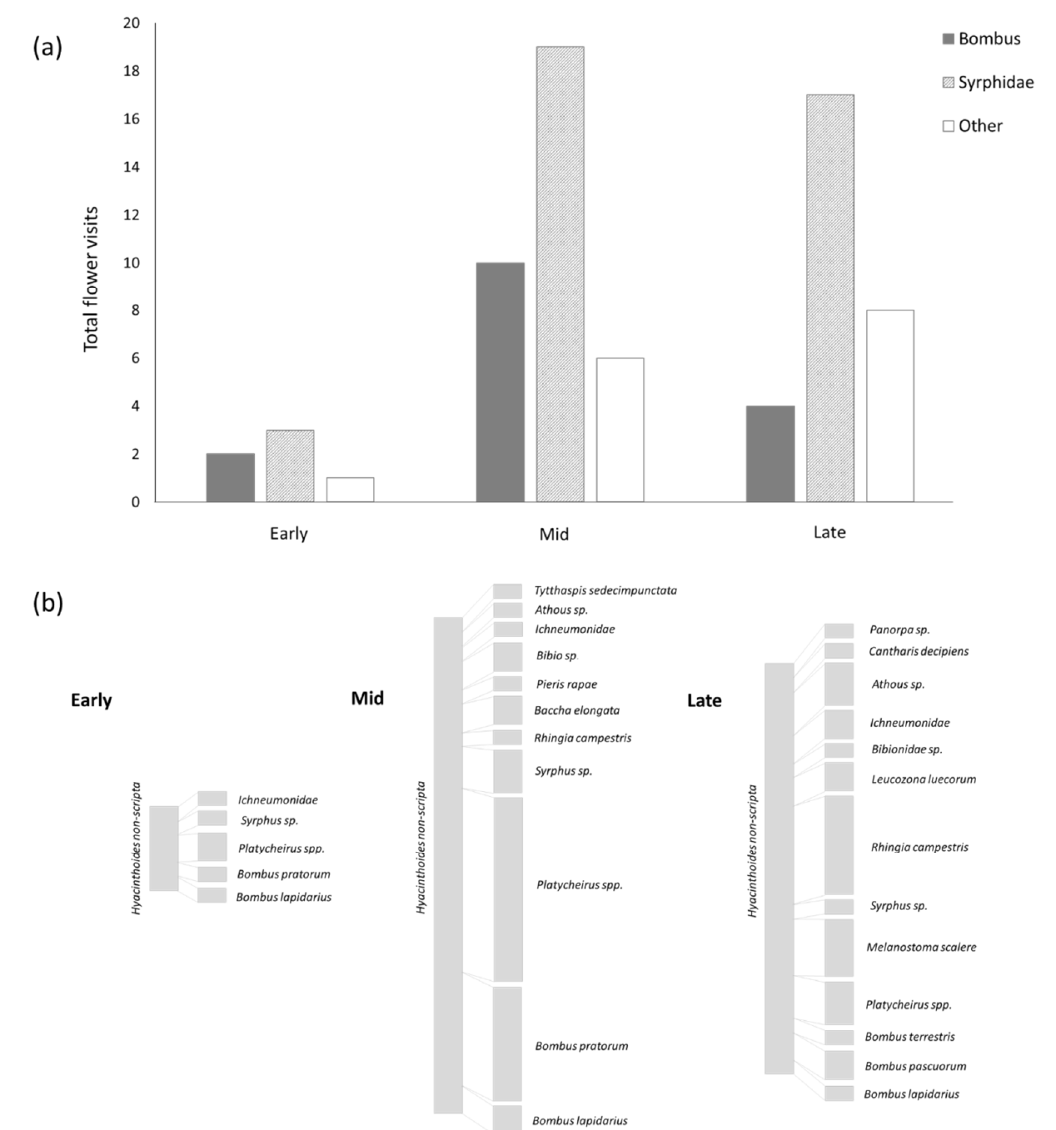
Figure 3. ( a ) Total number of flower visits made by bumble bees ( Bombus ), hoverflies (Syrphidae) and all other flower visitors during each time period. Data are based on 30 min observations at each array for each time period during flowering. ( b ) Sankey diagram of the visitation network during each flowering time period. Bar size is proportional to total number of visits by each taxon during each time